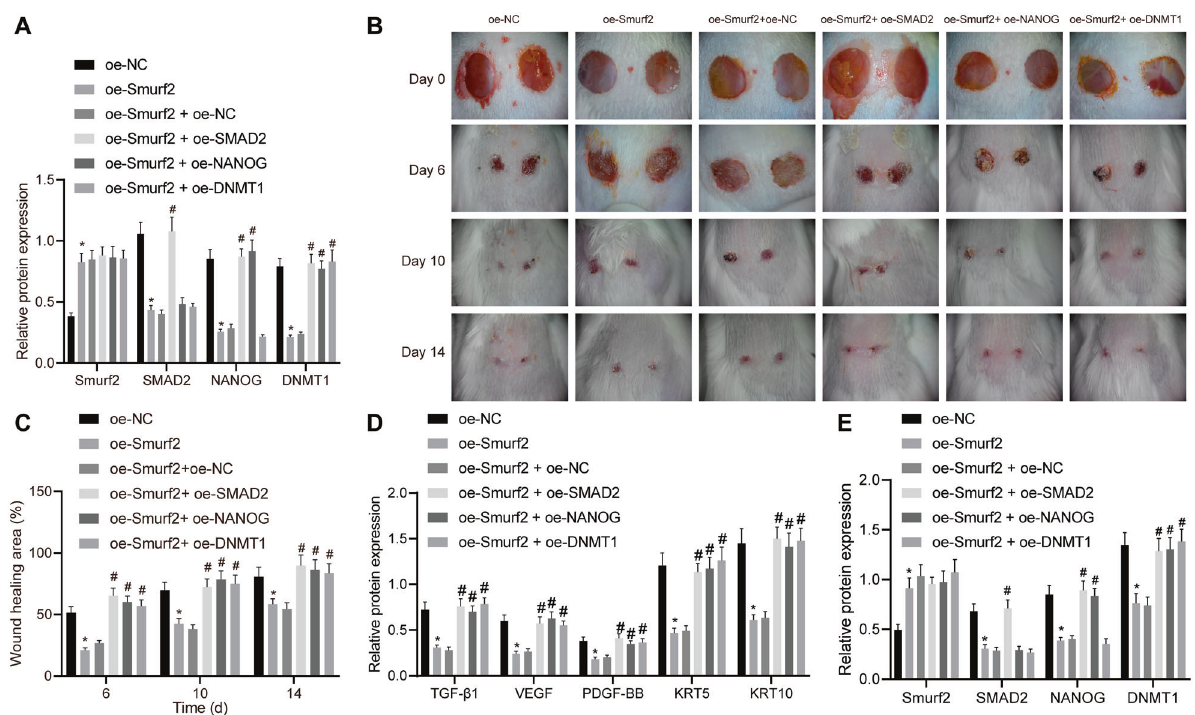
Fig. 6 Smurf2 degrades SMAD2 to prevent the activation of NANOG and DNMT1 and hence to reduce epidermal wound healing in mice. A Smurf2, SMAD2, NANOG and DNMT1 protein levels in the wounded tissues from mice on day 10 measured by western blot assay. B Representative images of wound area in mice on the days 0, 6, 10, and 14. C Wound healing area in mice on the days 0, 6, 10, and 14. D Protein expression of growth factors TGF- β 1, VEGF, PDGF-BB, KRT5 and KRT10 in the wounded tissues from mice measured by western blot assay. E Smurf2, SMAD2, NANOG and DNMT1 protein levels in the wounded tissues from mice on day 18 measured by western blot assay. * p < 0.05 vs. oe-NC group; # p < 0.05 vs. oe-Smurf2 + oe-NC group. Data are expressed as mean ± standard deviation. Data between multiple groups were compared by one-way ANOVA with Tukey ’ s post hoc test. n = 6.